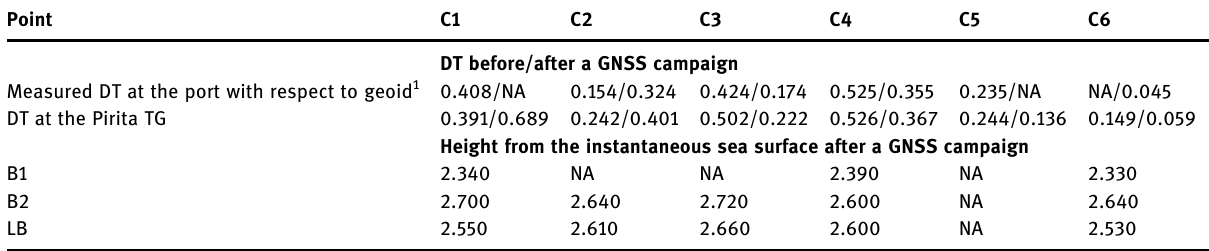
LB Units are in meters. 1 DT was measured before and after a campaign from the benchmark on the